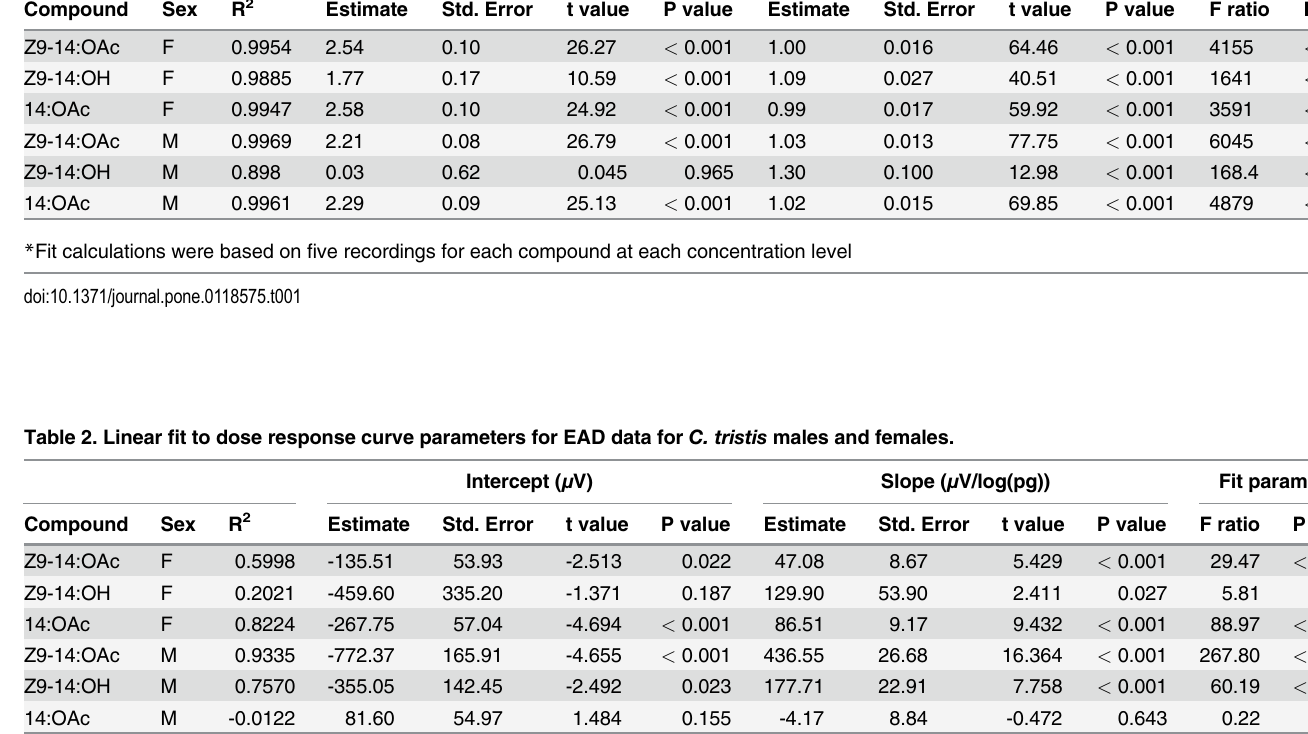
Table 1. Linear fi t to dose response curve parameters for FID data for C. tristis males and females. Intercept (Log( μ V+1)) Slope (Log( μ V+1)/Log(pg)) Fit parameters